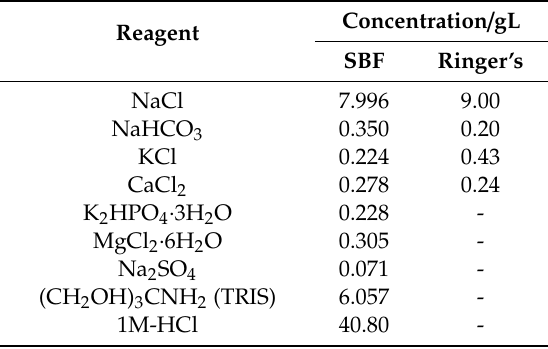
Table 2. Reagents for SBF (pH: 7.40) and Ringer’s solutions (pH: